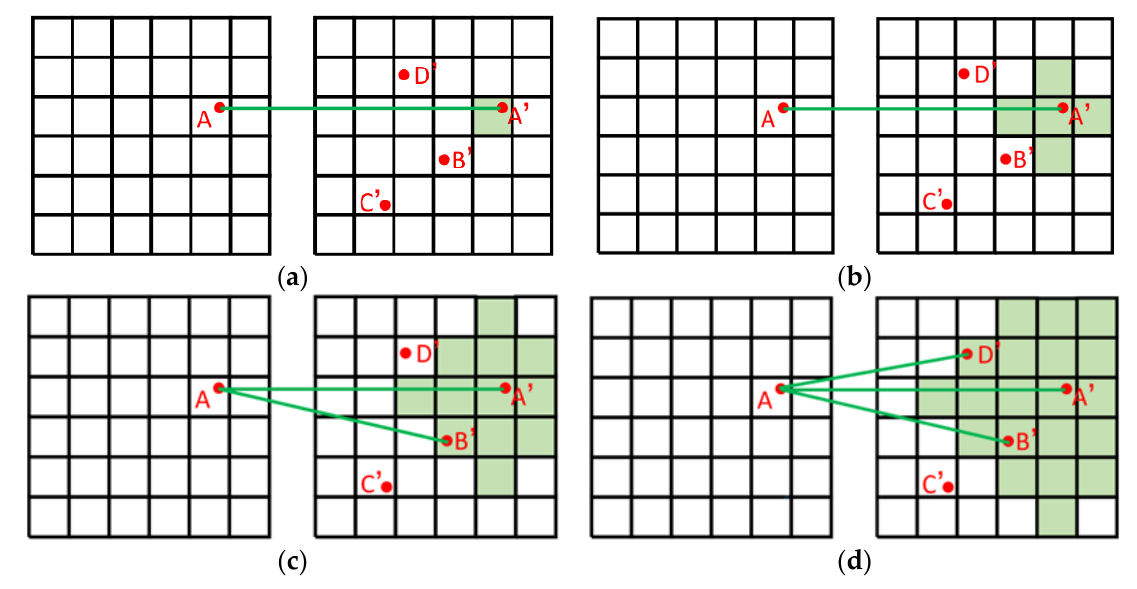
Figure 8. Effect of coordinate descriptor threshold on matching. The green grid indicates the range that can be matched, the green line indicates that the pair of point can be matched, and the pair of point without a connection cannot be matched. ( a , b , c ) and ( d ) respectively show the range that can be matched and the number of possible matching point pairs when the coordinate descriptor threshold T changes ( a ) T = 1; ( b ) T = 2; ( c ) T = 3; ( d ) T = 4.